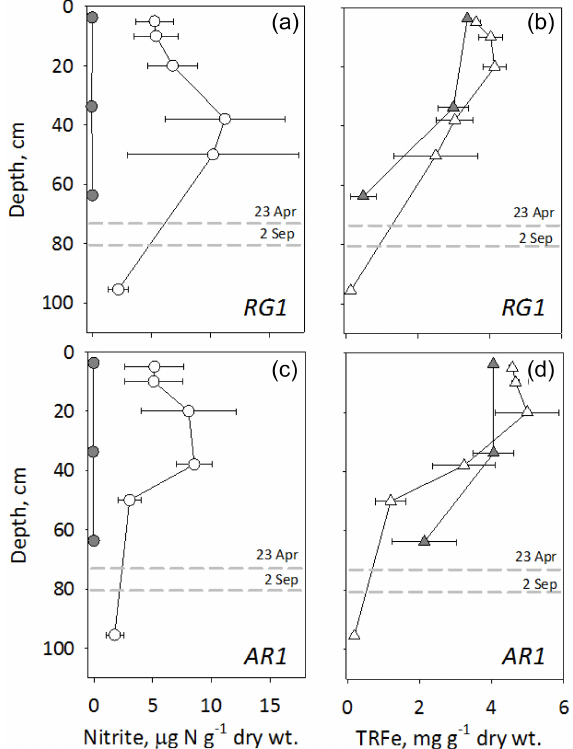
Figure 2. Nitrite-N (a, c) and total reactive iron, TRFe (b, d) in undisturbed soil cores were collected at RG1 and AR1 on 23 April (DOY 113; white symbols) and 2 September (DOY 245; grey sym- bols). Results shown are mean and standard error ( n = 2). At RG1 , fertilisation had taken place 1 week earlier, but a two-sample t test did not find evidence for any effect on NO − availability ( p = 0 . 19). 2 The dotted lines indicate WT level on the two sampling